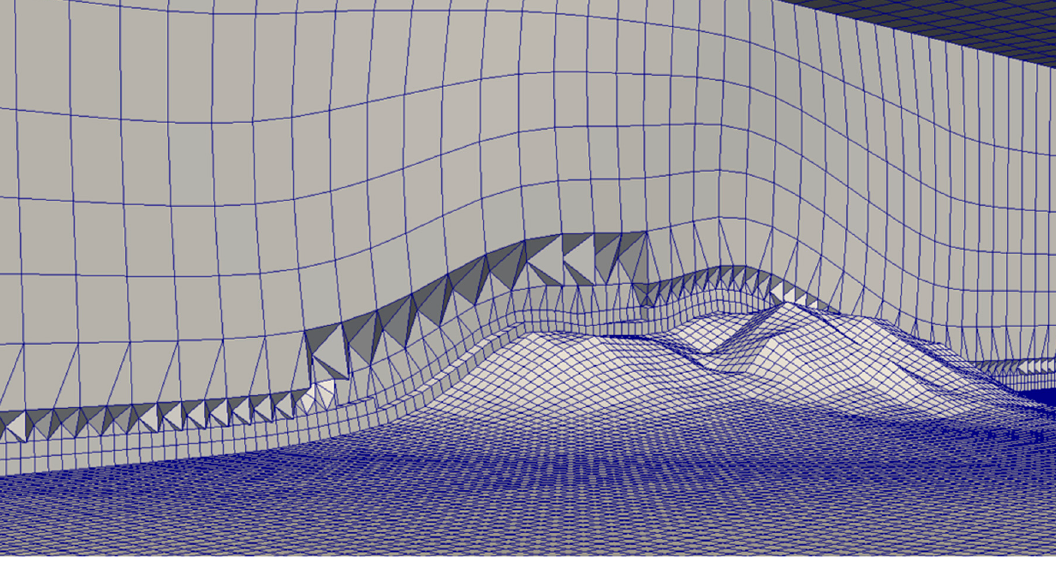
Figure 1. Slice through the computational mesh used for Big Southern Butte.